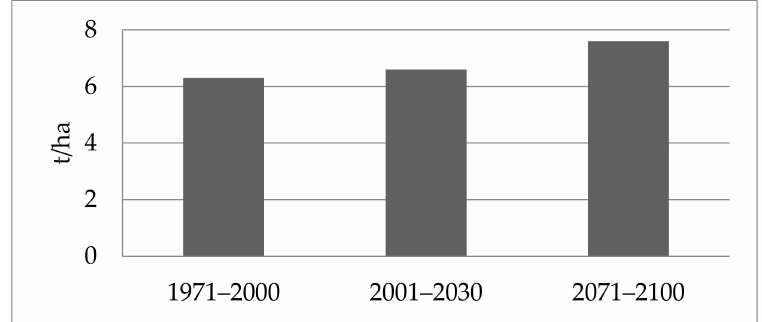
Figure 6. The mean grain yield of rain-fed spring barley over the baseline (1971–2000) and in the projected climate scenarios (2001–2030 and